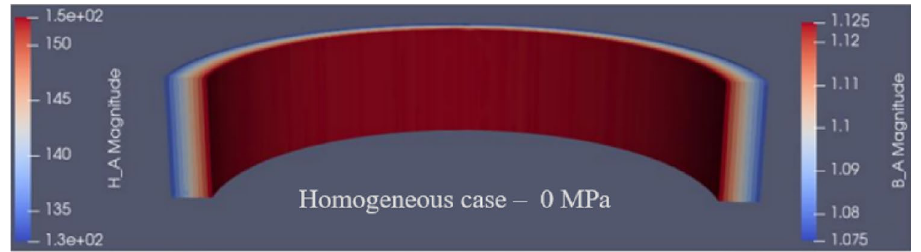
Figure 28. Code_Carmel simulation - Homogeneous case 0 MPa (B = 1.1